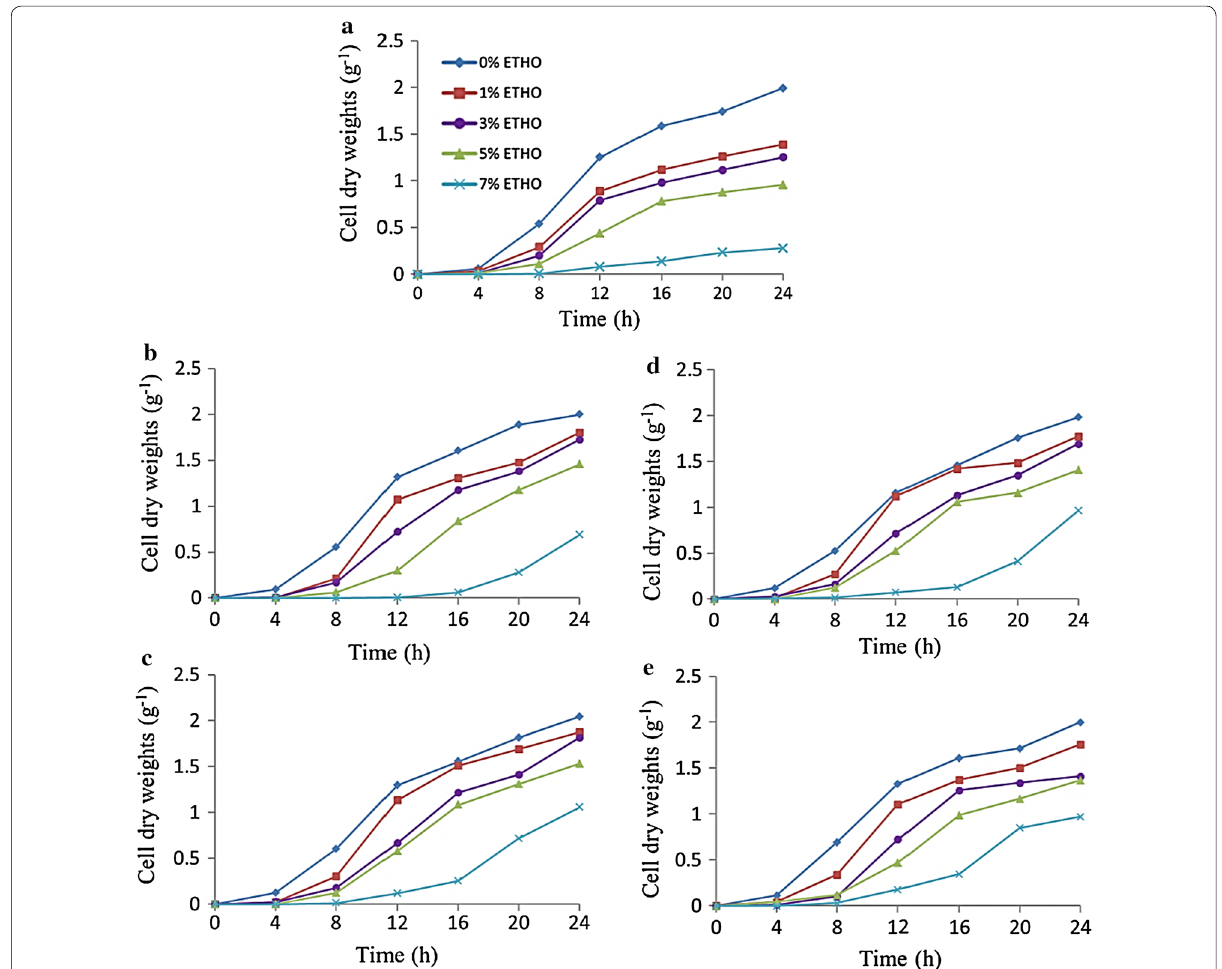
Fig. 5 a Growth curve for the R‑control strain and b – e growth curves for the best mutant strains (R‑M3C49‑P10, R‑M18C5‑P10, R‑M17C4‑P20 and R‑M9C2‑P20) obtained by the Ep‑PCR reaction by using 10 and 20% MnCl 2 concentrations, respectively. These strains were inoculated into the YPDT medium at different levels of ethanol concentrations ( ) 0% ETHO, ( ) 1% ETHO, ( ) 3% ETHO, ( ) 5% ETHO and ( ) 7%